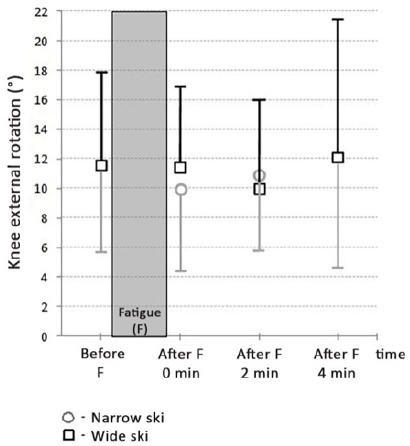
Figure 3. External tibial rotation in a prefatigued state (before F) and at different times after fatigue (after F) with two different ski waist-widths.